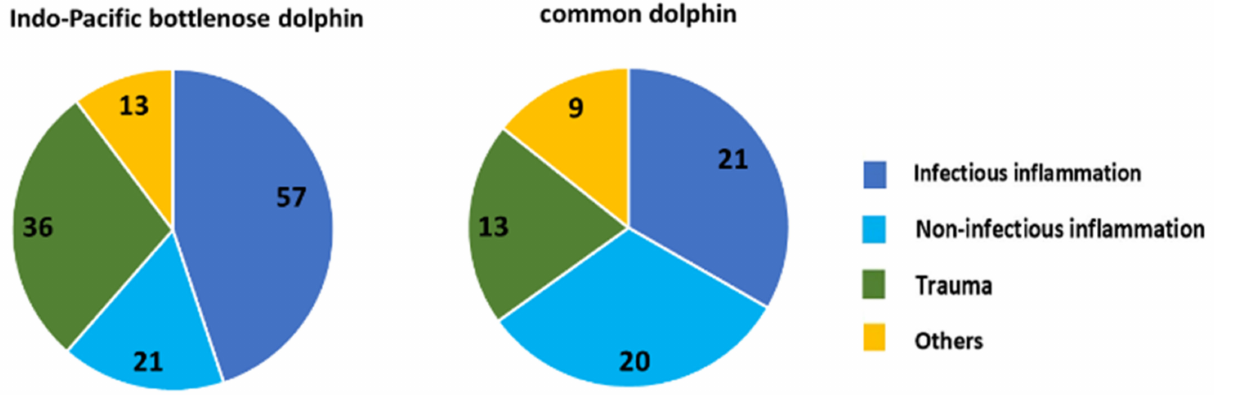
Figure 5. Proportional representation of the types of pathological changes in the Indo-Pacific bot- tlenose dolphin ( Tursiops aduncus) and common dolphin ( Delphinus delphis ) from the St Vincent Gulf Bioregion, South Australia, during 2009–2020. Numbers are the counts of cases in each category. The highest prevalence of inflammation for dolphins was pneumonia, which was found in 68% (55/80) of Indo-Pacific bottlenose dolphins and 62% (25/40) of